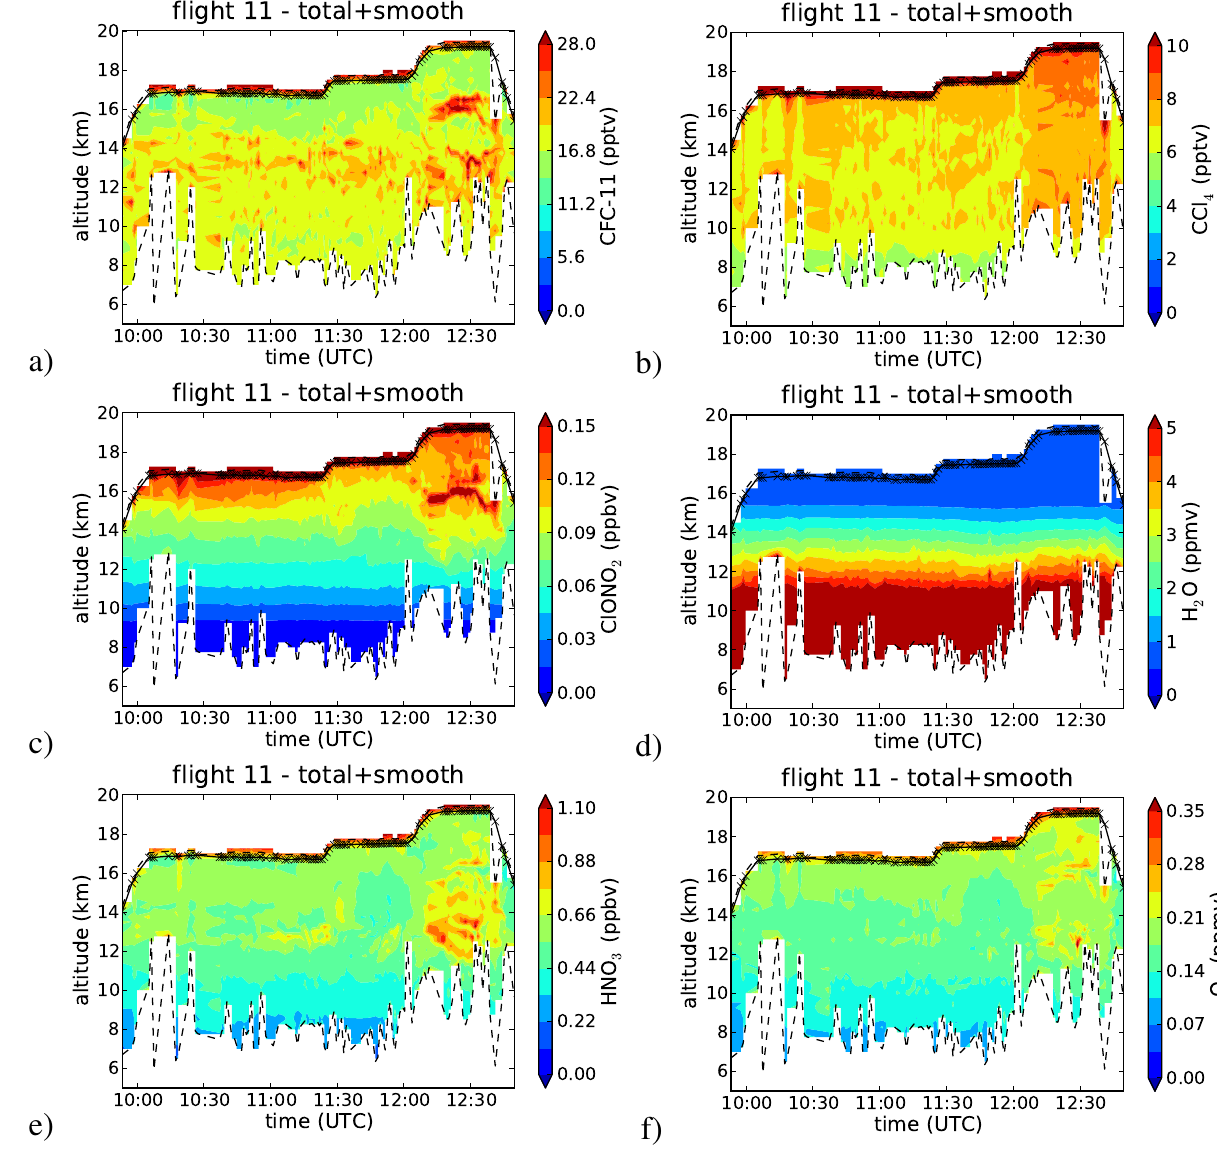
Fig. 6. “Total+smooth” errors for CCl 4 and CFC-11, ClONO 2 , H 2 O, HNO 3 and O 3 . graph was chosen to be consistent with our error bar, im- plying that we cannot significantly resolve more details than